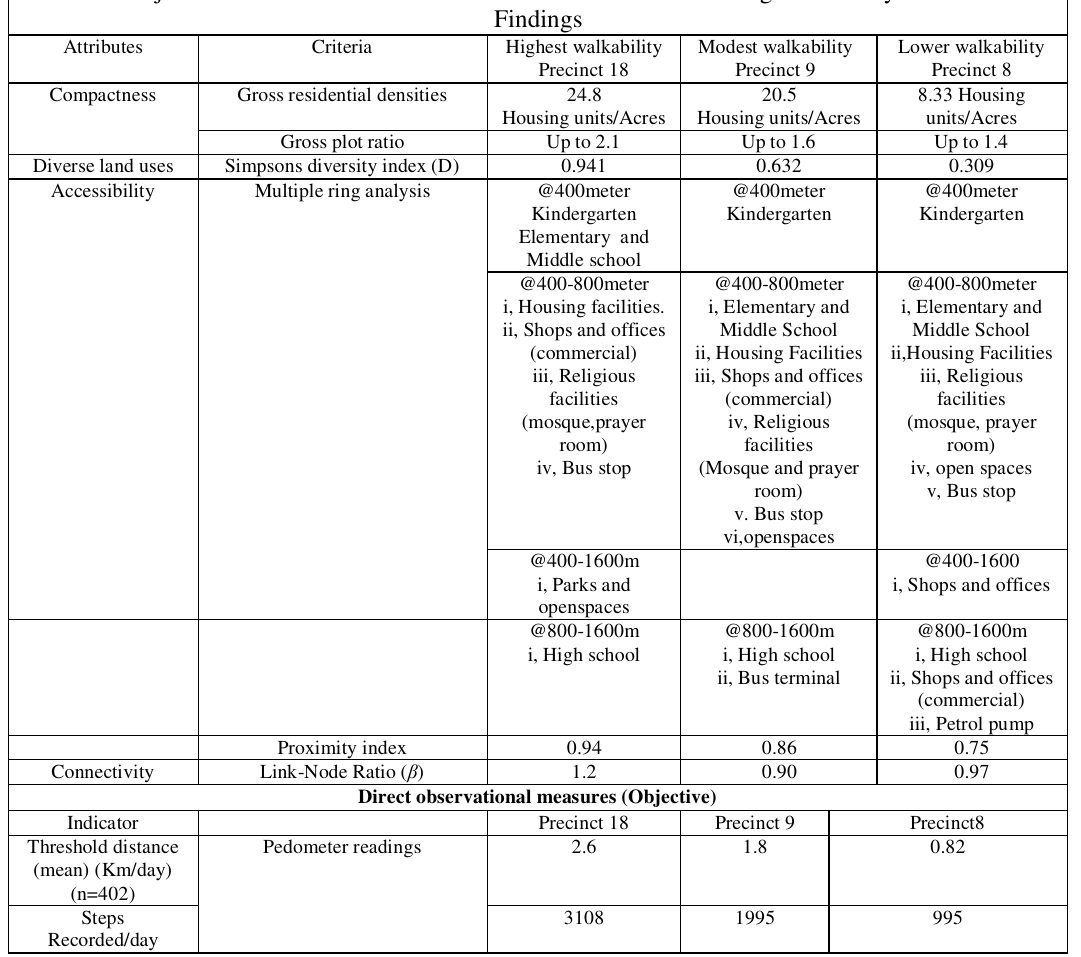
Table 11: Objective Measures of Built Environment Attributes Influencing Walkability and